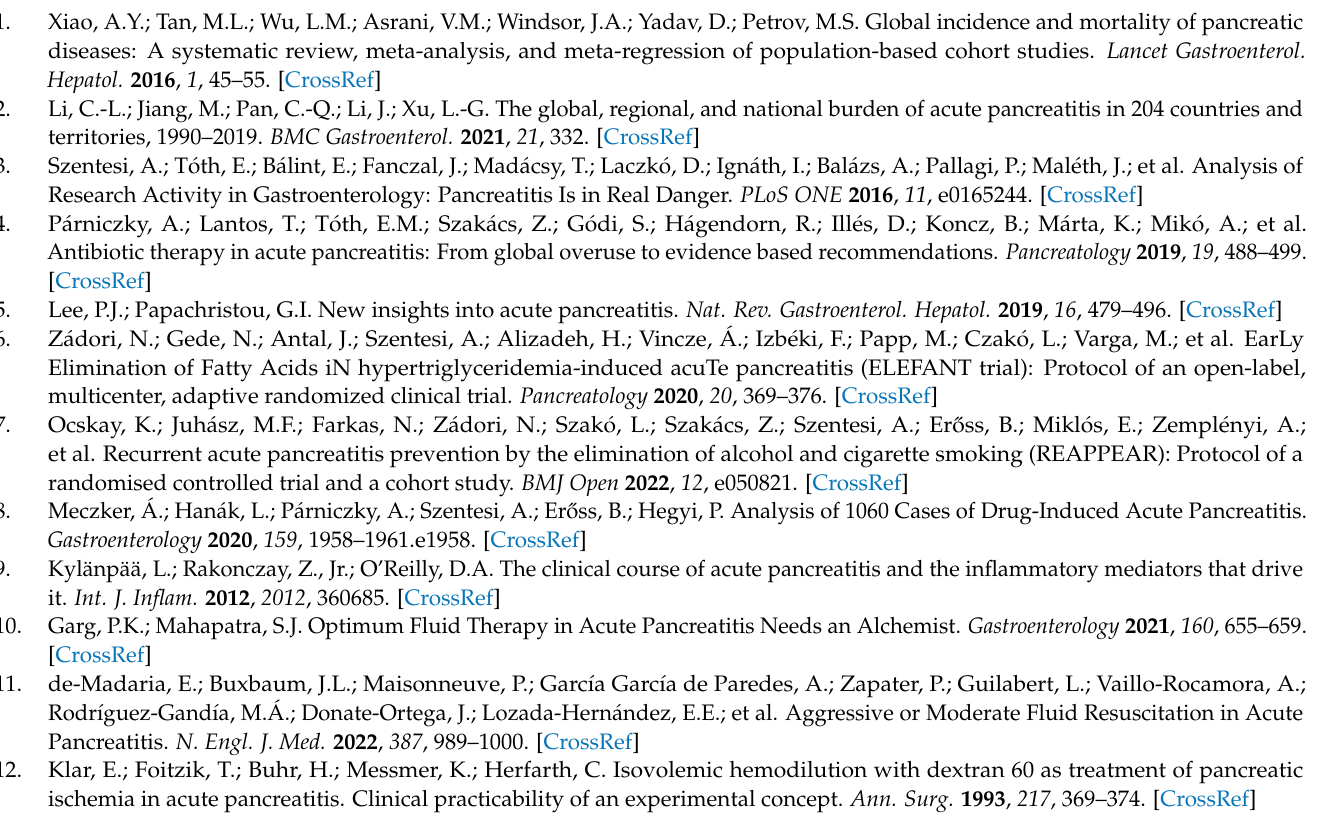
mortality; Figure S4. Length of hospital stay; Figure S5. Need for intensive care; Figure S6. Organ failure; Figure S7. Local complications; Figure S8. Necrosis; Figure S9. Pseudocyst; Figure S10. Systemic inflammatory response syndrome; Figure S11. C-reactive protein levels (mg/dL) at 24, 48 and 72 h after randomization; Figure S12. Amount of fluid administered in the first 24 h after randomization; Table S1. Detailed results of GRADE assessment. Table S2. References of the included